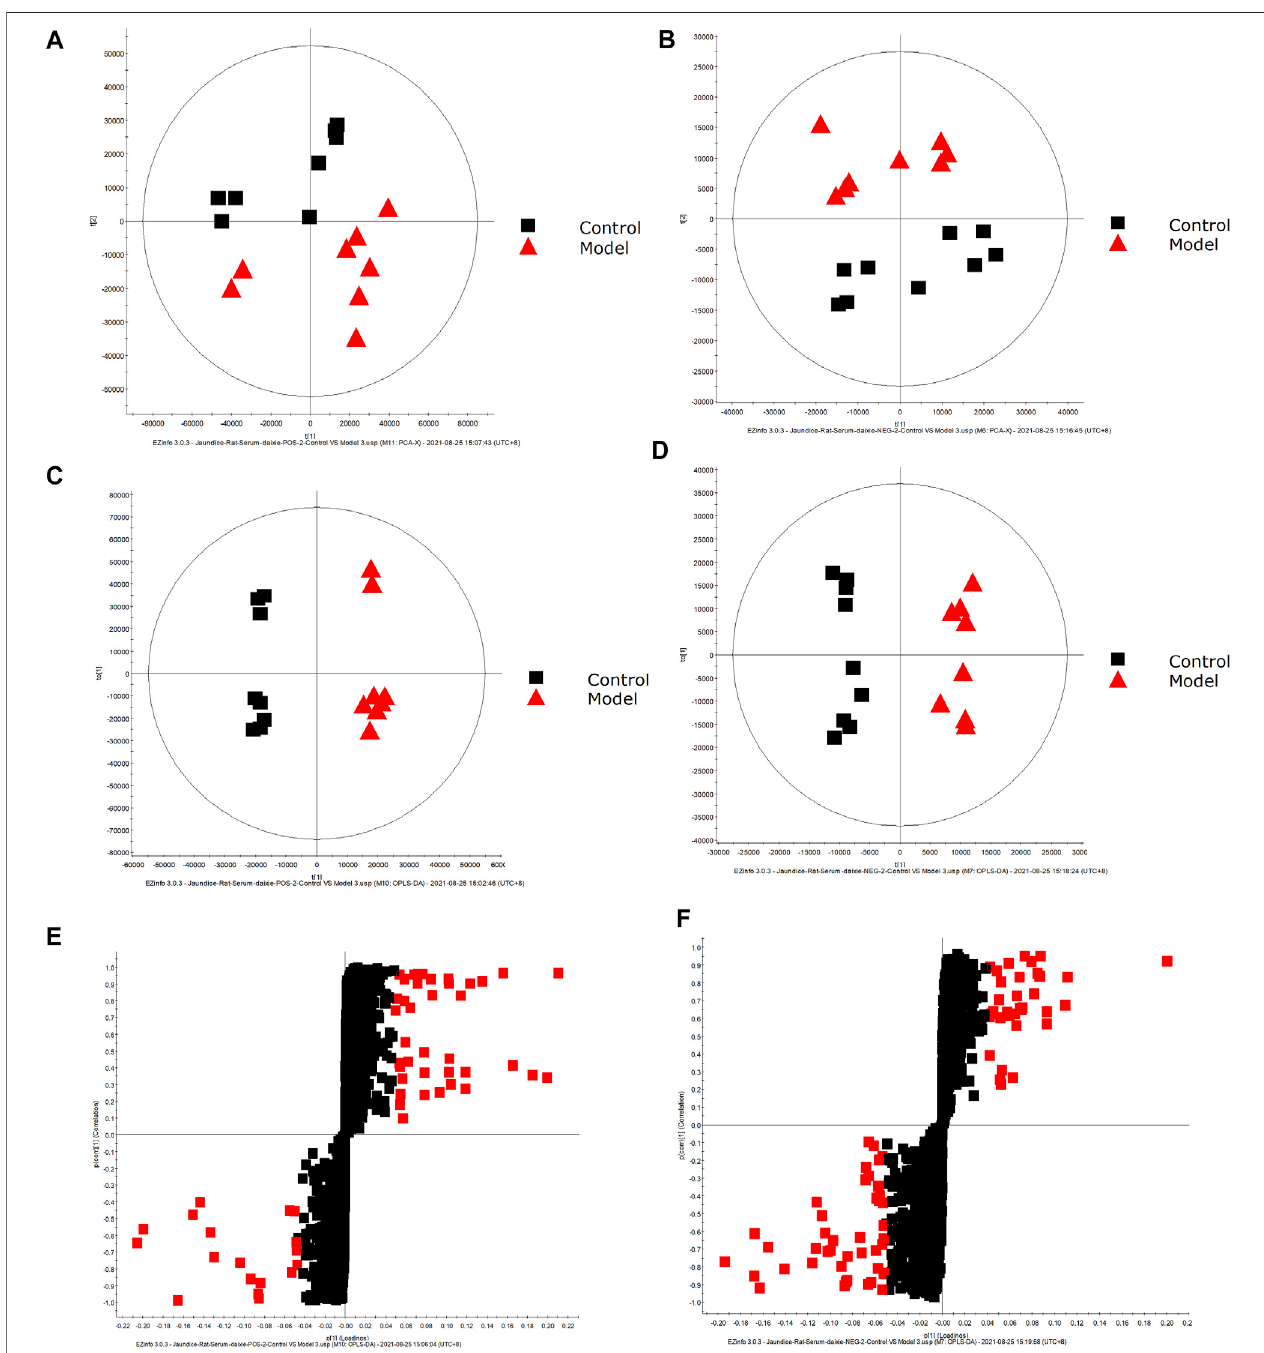
FIGURE 2 | Metabolic pro fi le characterization and Multivariate. (A) PCA score plots for the control and model groups in positive mode. (B) PCA score plots for the control and model groups in negative mode. (C) OPLS-DA score plots for the control and model groups in positive mode. (D) OPLS-DA score plots for the control and model groupsin negative mode. (E) MetabolitebiomarkersintheS-plotbetweenthecontrol andmodel groupsin positivemode. (F) Metabolite biomarkers intheS-plot between the control and model groups in negative mode.